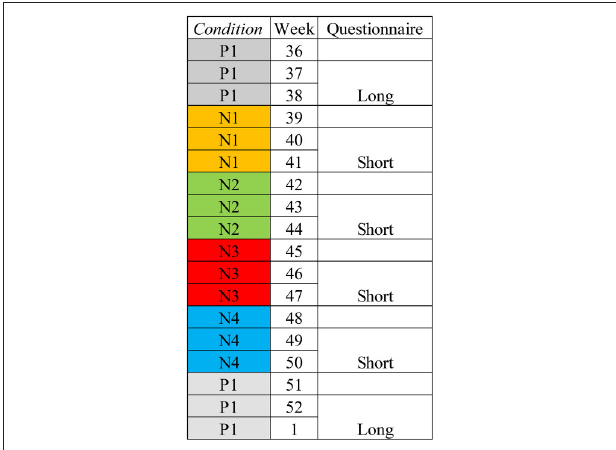
FIGURE 3 | The layout of the studied open-plan office. The office involves 54 fixed workstations (18 trefoils) and more than 30 seats in collaboration zones and pods. Triangles indicate the position of masking loudspeakers.